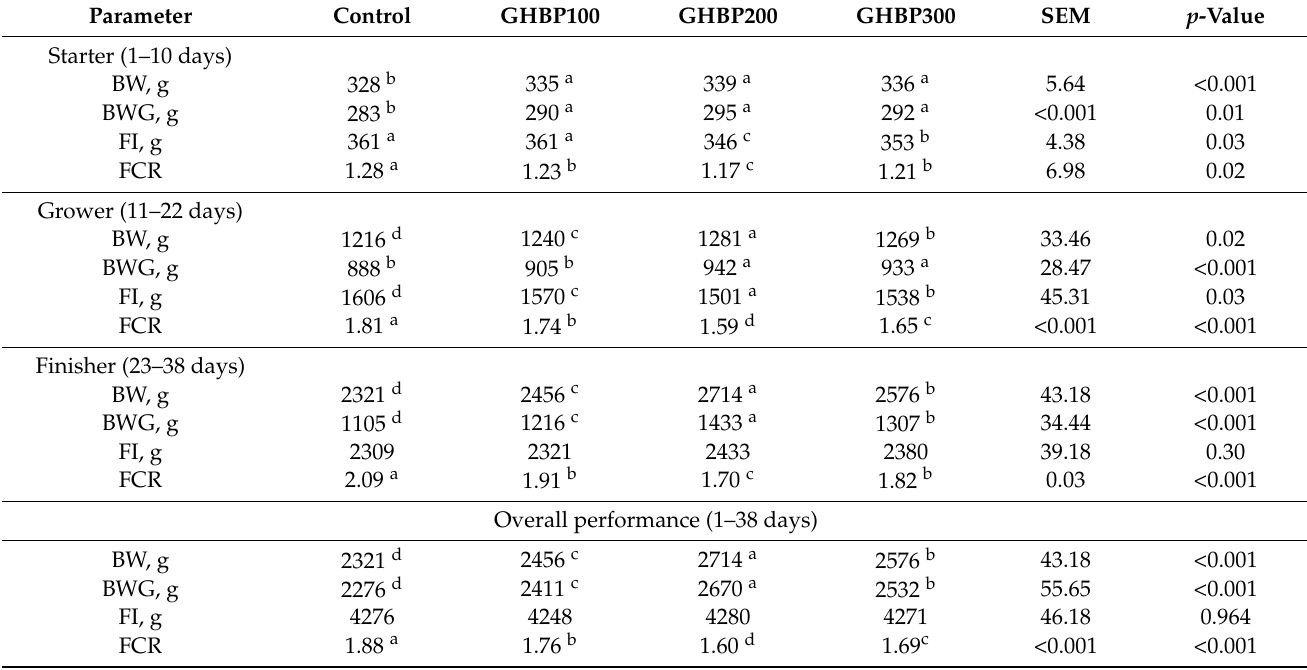
Table 4. Effect of GHBP on the growth performance of broiler